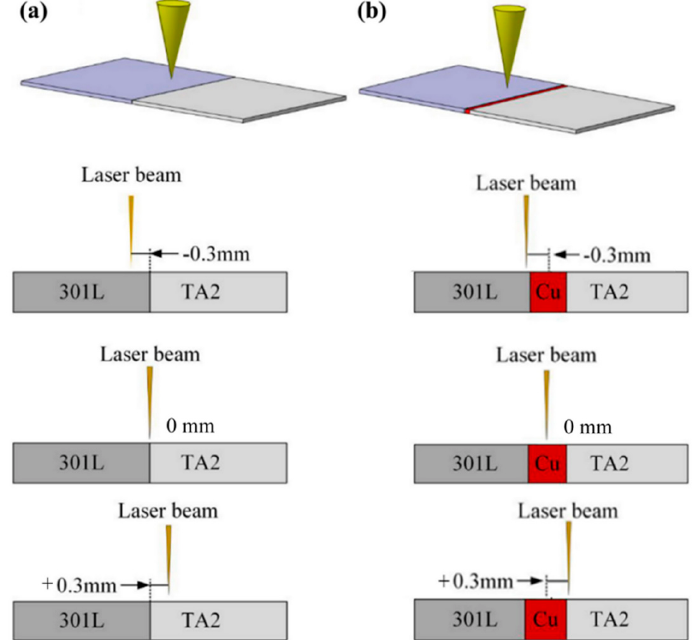
Figure 1. Schematic diagram of laser welding with three kinds of offsets: ( a ) without intermediate layer; ( b ) with Cu intermediate layer of 0.5 mm thick.